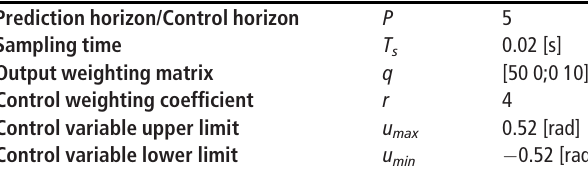
Table 5 Parameters of the lateral control